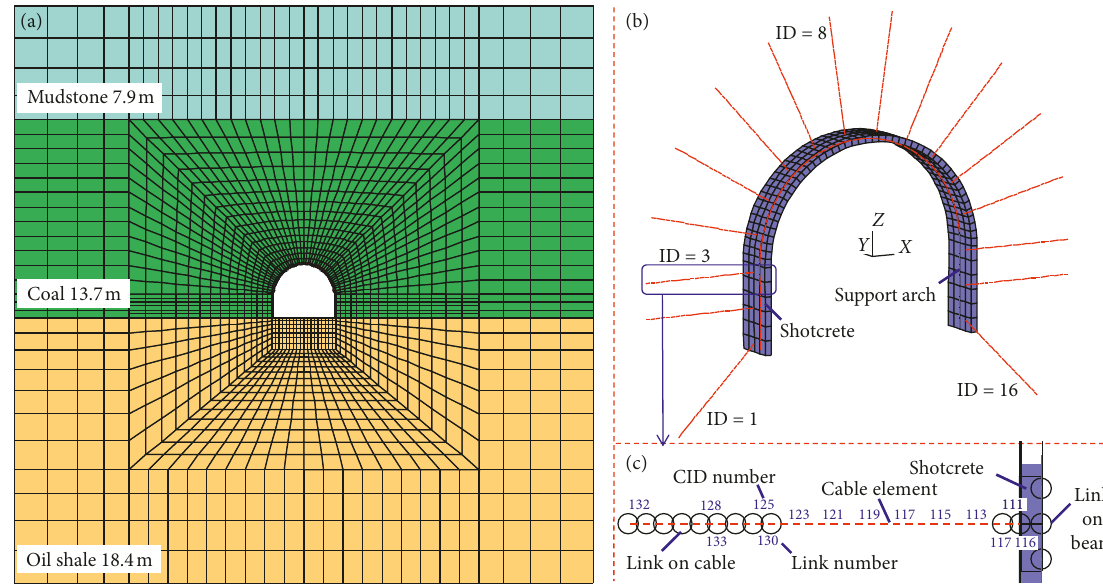
Figure 2: Numerical model. (a) Roadway and surrounding rocks. (b) Shotcrete layer, supporting arch, and rock bolts. (c) Rock bolts model details. Table 2: Mechanical parameters of surrounding rock